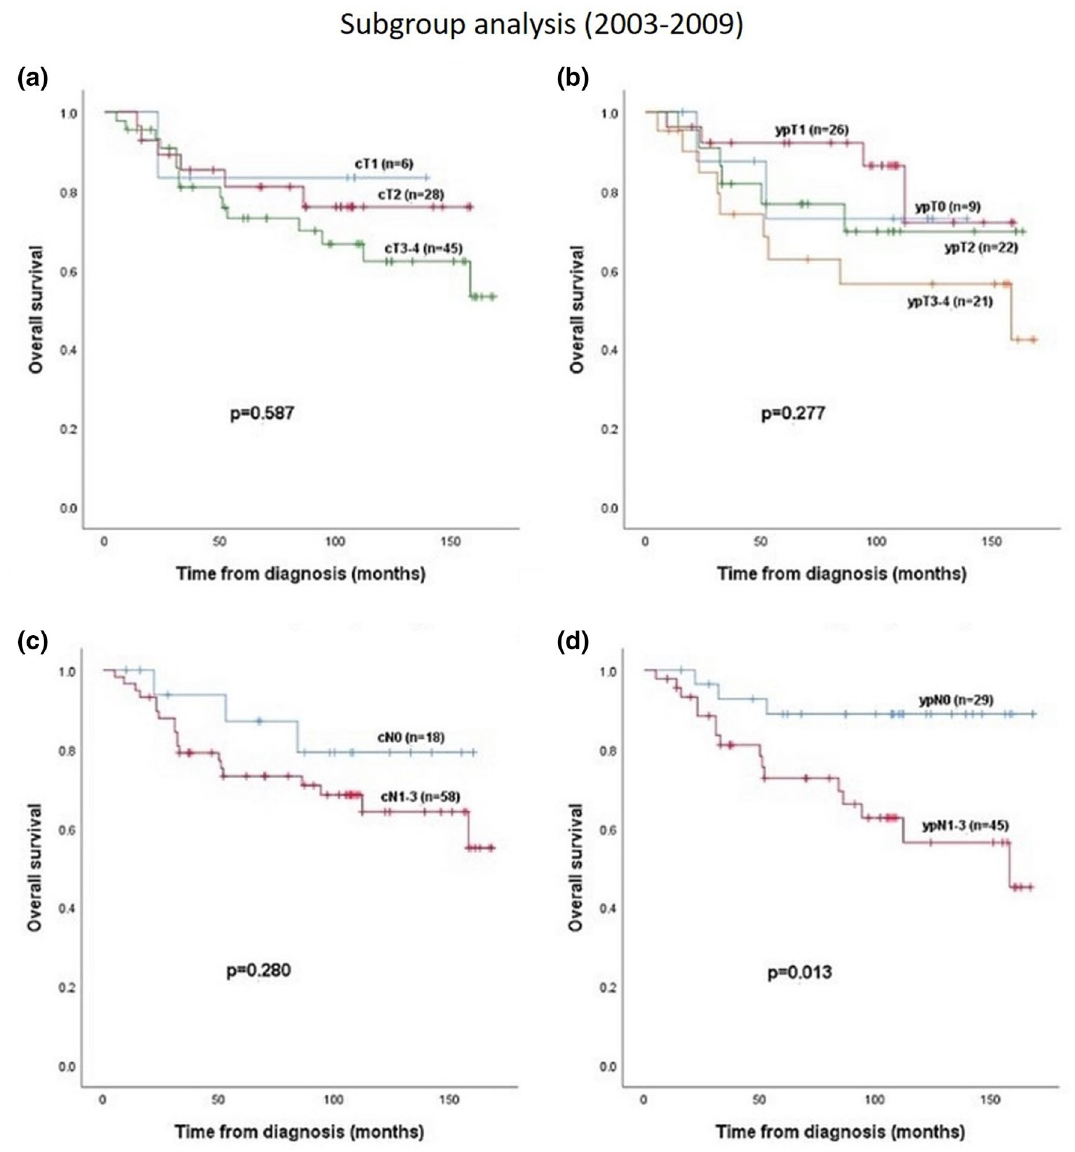
Figure 3. Overall survival in subgroup 1 (2003–2009) in relation to ( a ) cT-stadium, ( b ) ypT-stadium, ( c ) cN-stadium and ( d )